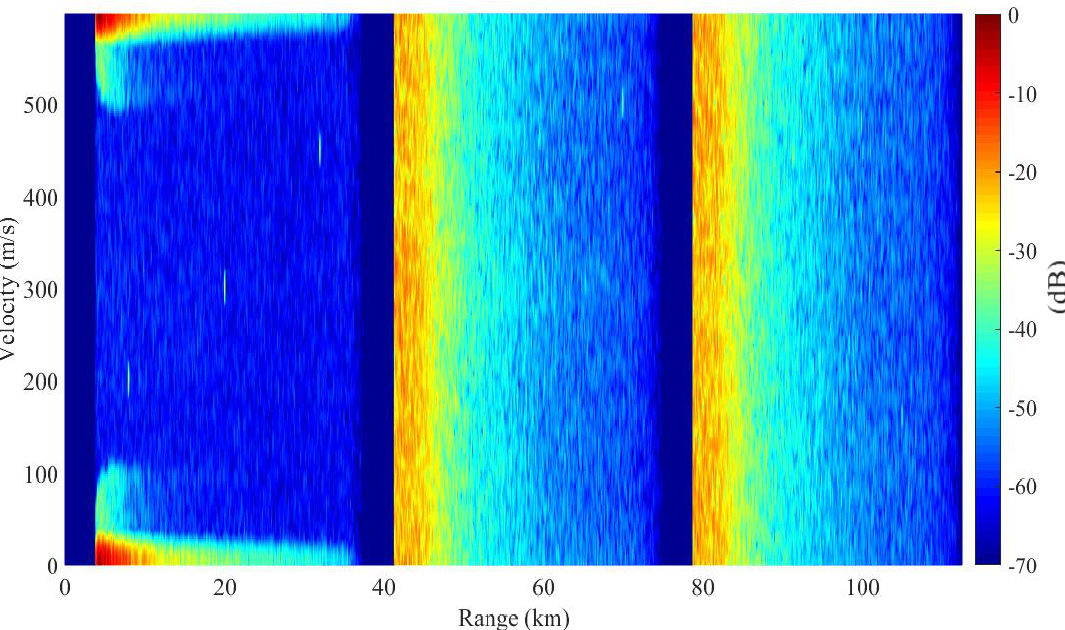
Figure 8. Range-Doppler resolution for the basic PD process.